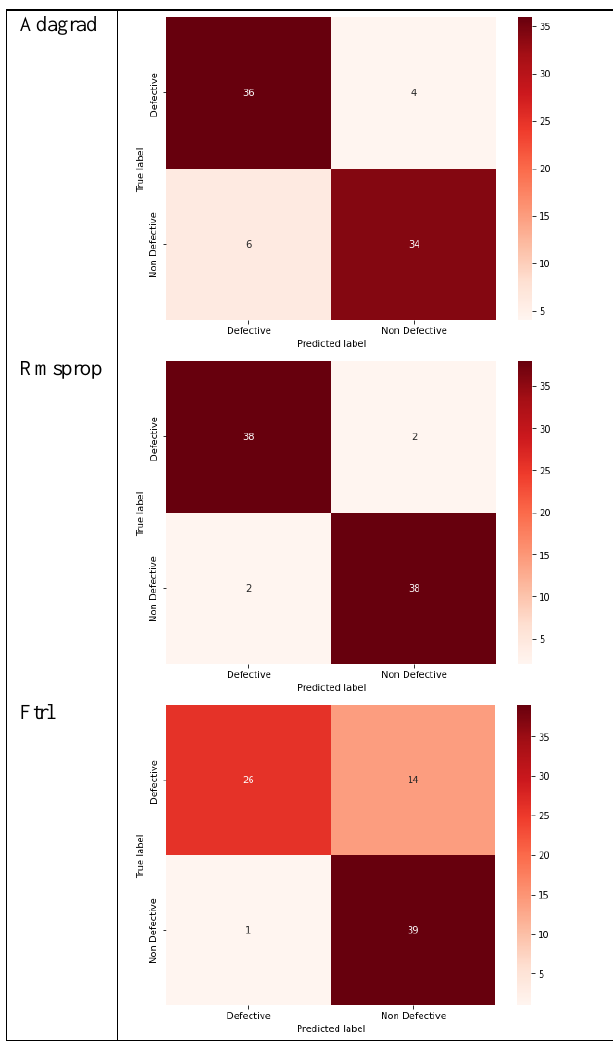
Table 5. Confusion matrix of